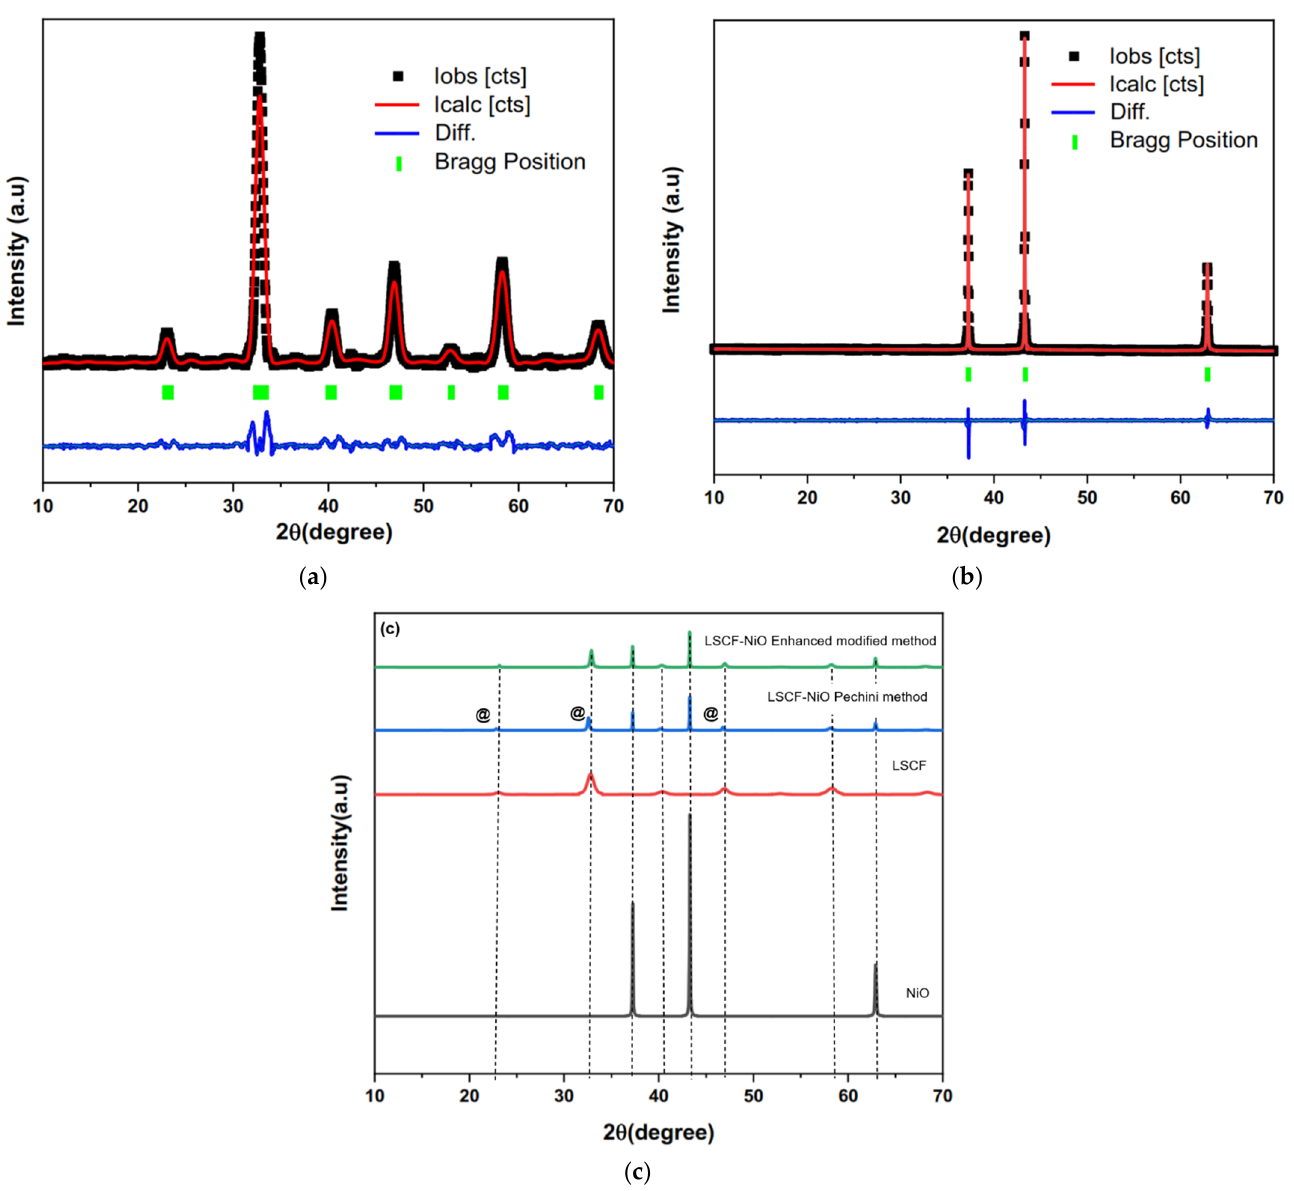
Figure 1. Rietveld refinement analysis of ( a ) LSCF powder heated at 800 °C for 6 h ( b ) Nickel oxide powder formed by heating Ni (NO 3 ) 2 at 800 °C for 3 h. ( c ) XRD pattern for the powder of LSCF-NiO composite powder (EM-SG method) in comparison with LSCF, nickel oxide, and LSCF-NiO (Pechini method from Rosli et al. [18]) pattern.